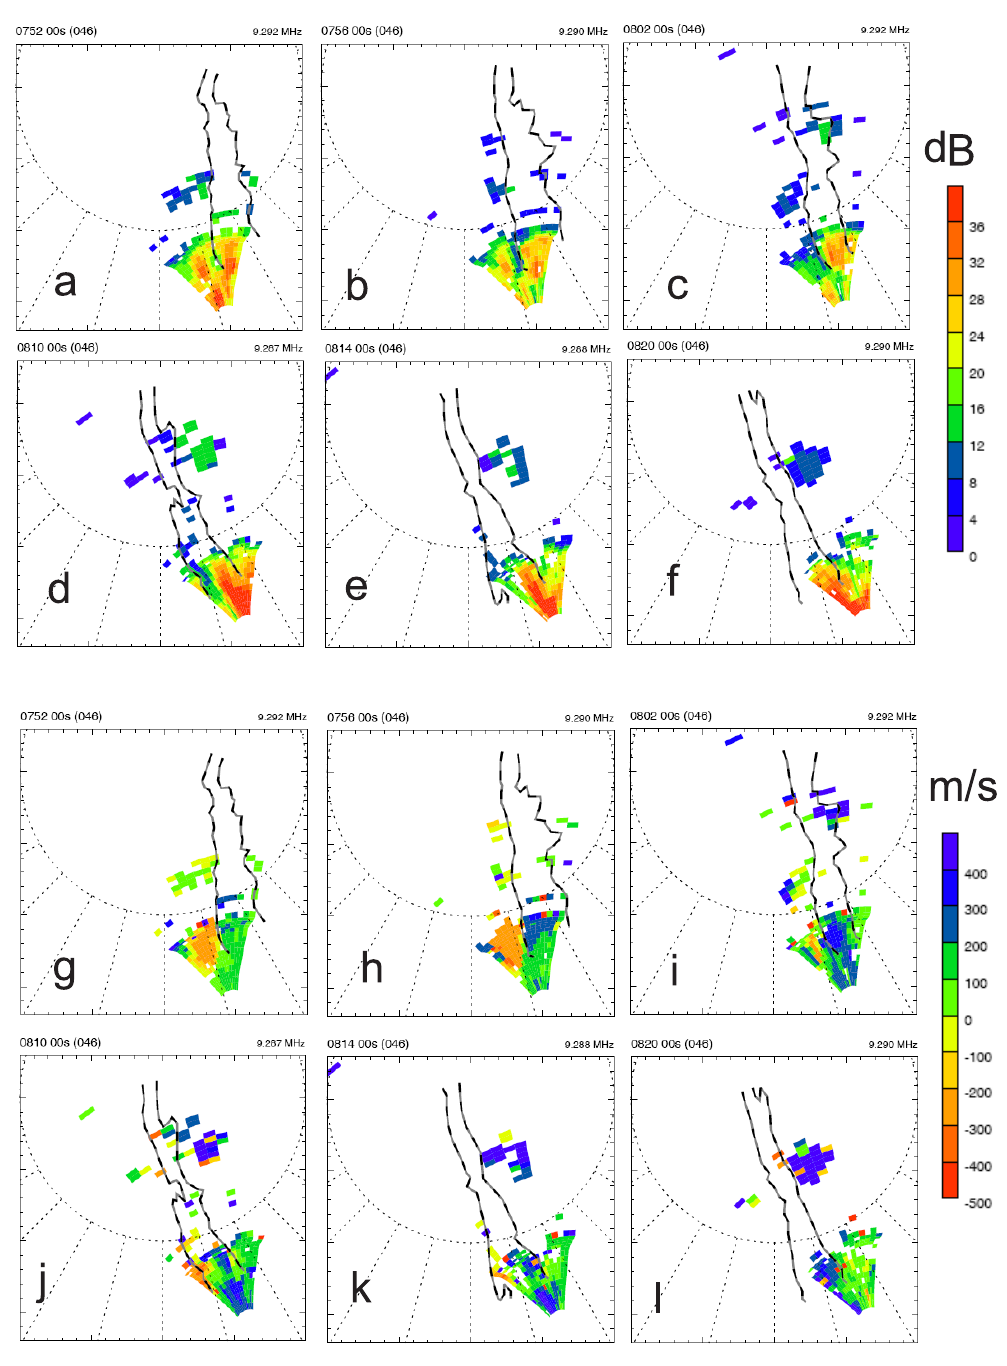
Fig. 5. Rankin Inlet HF (a–f) echo power and (g–l) velocity maps (positive: toward the radar) and locations of the auroral luminosity at closest time for the entire event